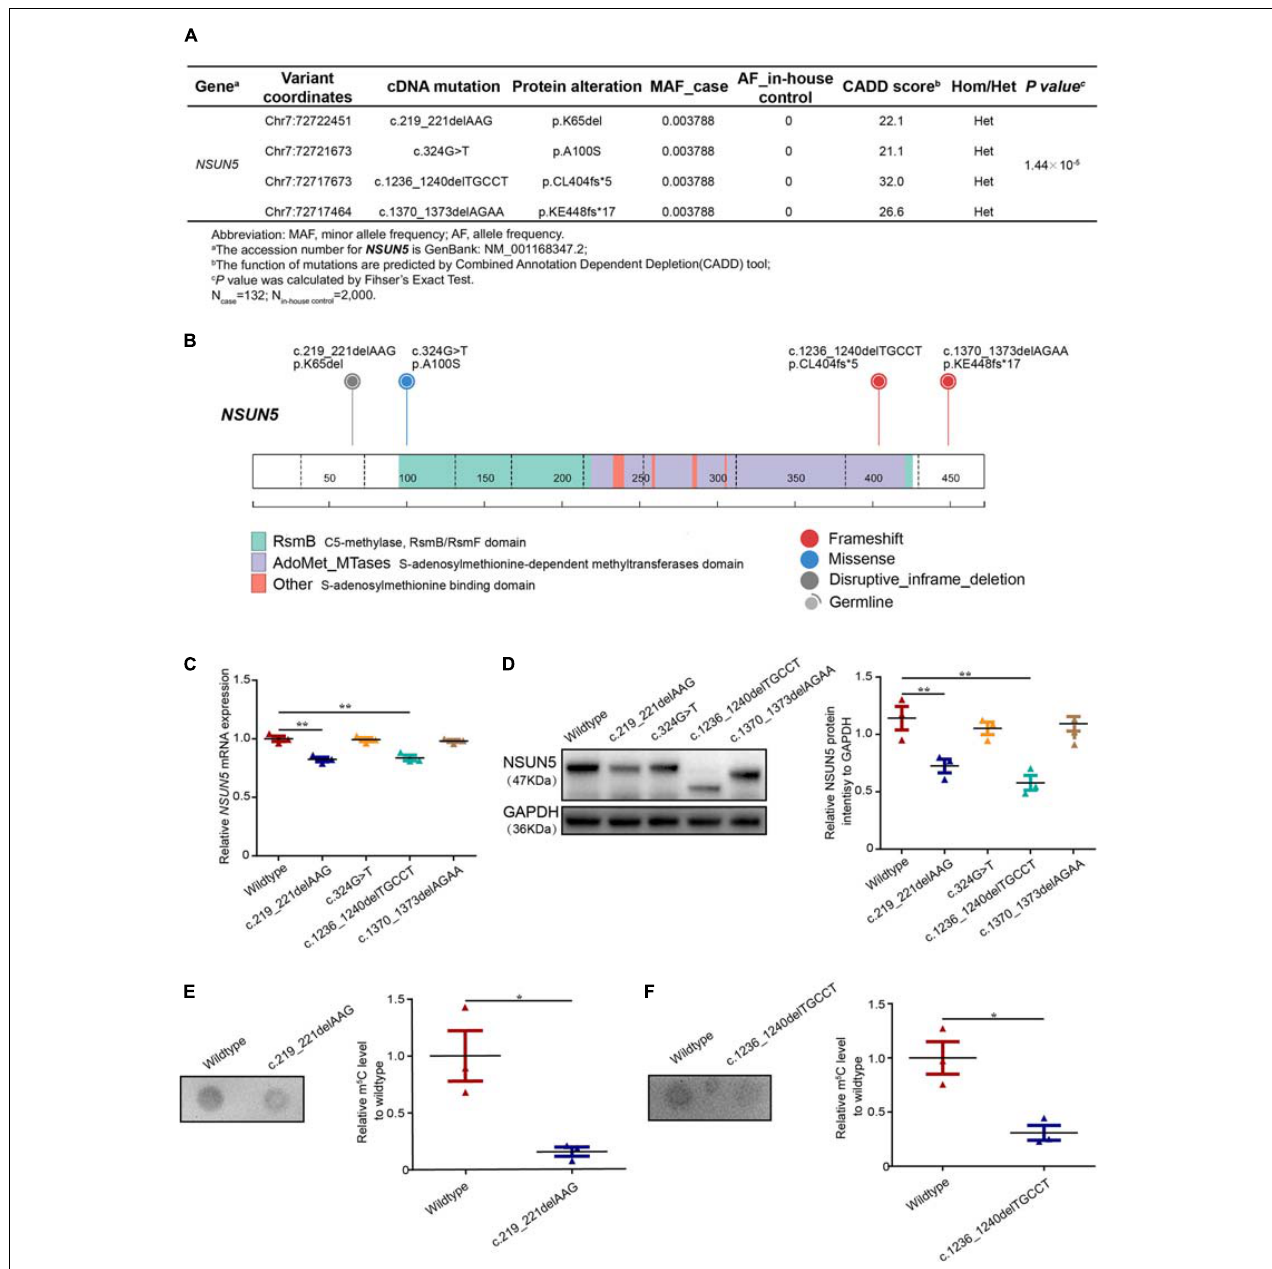
FIGURE 1 | Deleterious NSUN5 mutations in TOF patients. (A) Predicted deleterious mutations and association with risk of TOF (132 TOF patients and 2,000 in-house controls). (B) Schematic representation of a NSUN5 structure with C5-methylase, RsmB/RsmF domain, S -adenosylmethionine -dependent methyltransferases domain and S -adenosylmethionine binding domain and the top were NSUN5 predicted pathogenic mutations identified in our study. Fisher’s exact test was used for statistical calculation. (C) Quantitative real-time PCR analysis of NSUN5 in mutant forms. (D) Western blot analysis of NSUN5 in mutant forms. (E,F) Dot blot analysis of m 5 C level in mutant forms. The values represent the mean ± SEM of three independent experiments. Unpaired Student’s t -test was used for statistical calculation. * P < 0.05, ** P < 0.01.